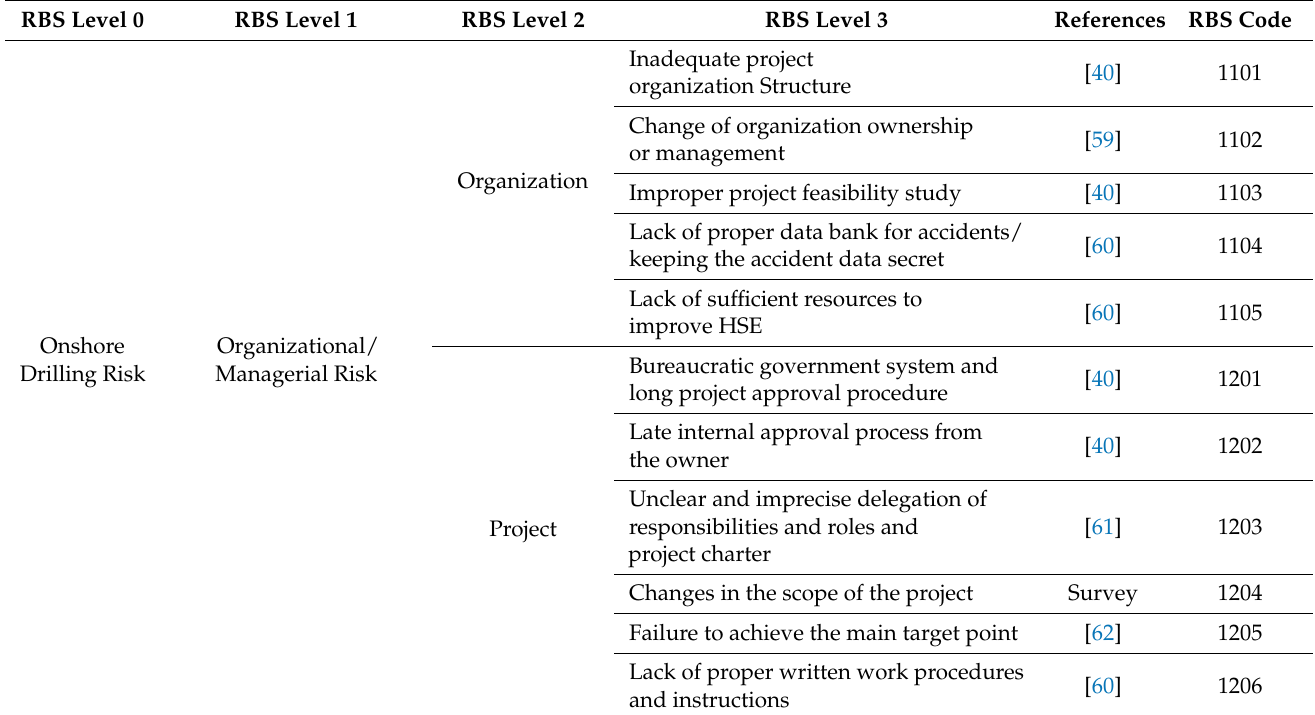
Table A1. Risk breakdown structure of drilling